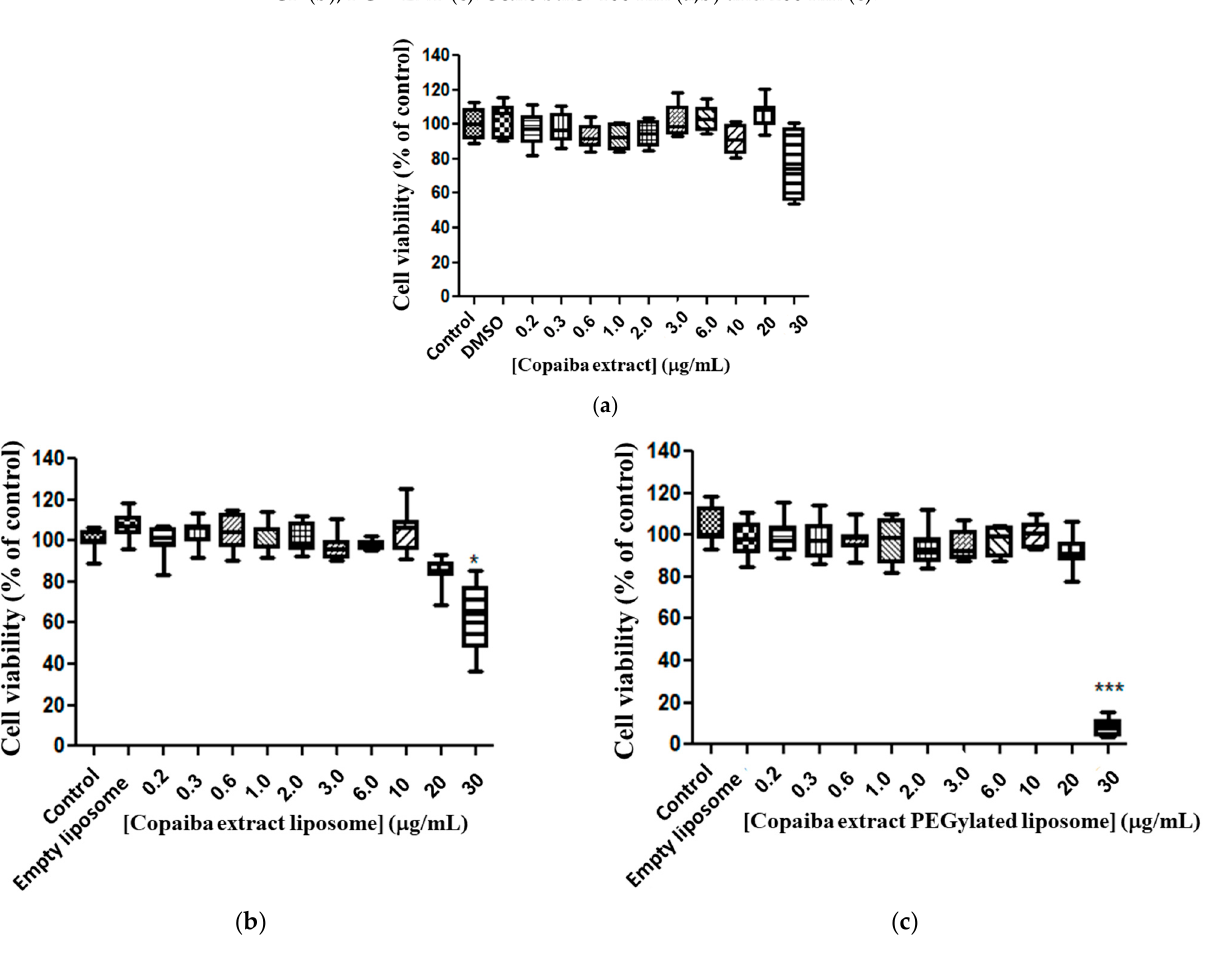
Figure 3. Cytotoxicity of copaiba extract in glioma line cell (C6). Exposure for 72 h, at doses of 0.2–30 μ g/mL. Copaiba extract ( a ), copaiba extract in liposome conventional (PC + CP) ( b ), copaiba extract in PEGylated liposome (Phospholipon, lipopeg and copaiba extract—PC + LP+ EXT) ( c ). Sta-